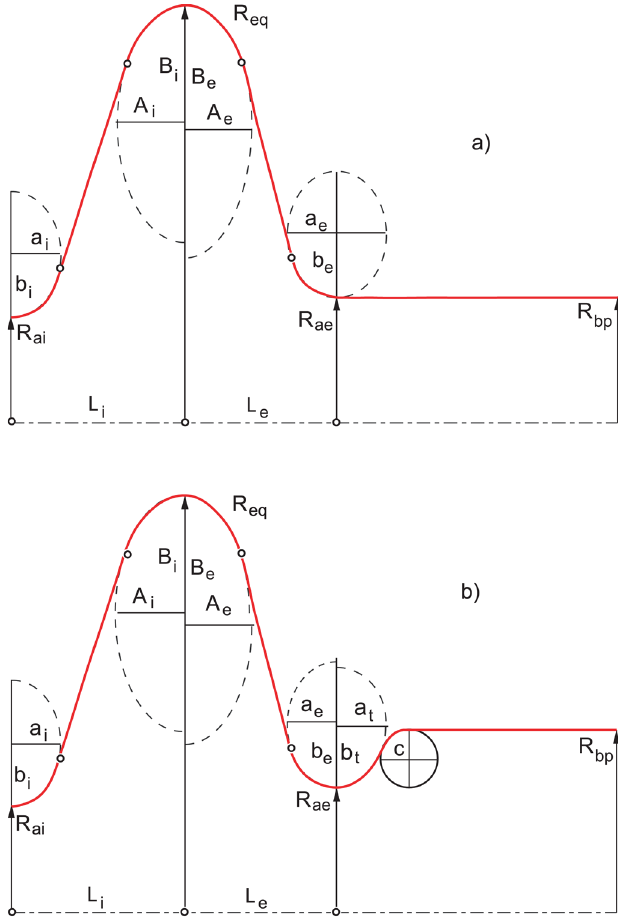
FIG. 6. (Color) Two possible end cells of a multicell cavity: with a simple transition to the beam pipe (a), and with an iris and a broader beam pipe